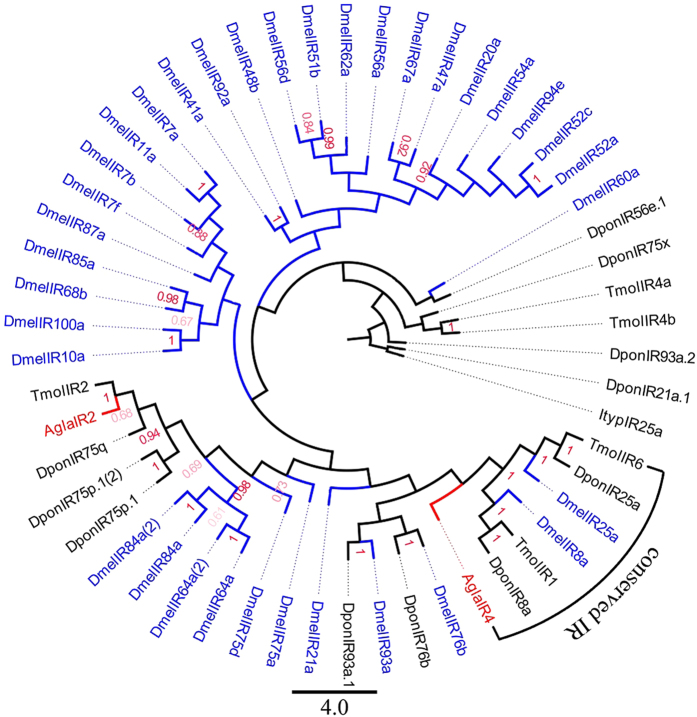
Neighbor-joining phylogenetic tree of candidate ionotropic receptor s (IRs).The NJ phylogenetic analysis of IRs of A. glabripennis (AglaGR, red) was performed with reference IRs of D. ponderosae (DponIR, dark), I. typographus (ItypIR, dark), T. castaneum (TcasIR, dark), Drosophila melanogaster (DmelIR, Diptera, blue), Bombyx mori (BmorIR, Lepidoptera, green), and Apis mellifera (AmelIR, Hymenoptera, purple). The stability of the nodes was assessed by bootstrap analysis with 1,000 replications, and only bootstrap values ≥0.6 are shown at the corresponding nodes. The scale bar represents 4.0 substitution per site.